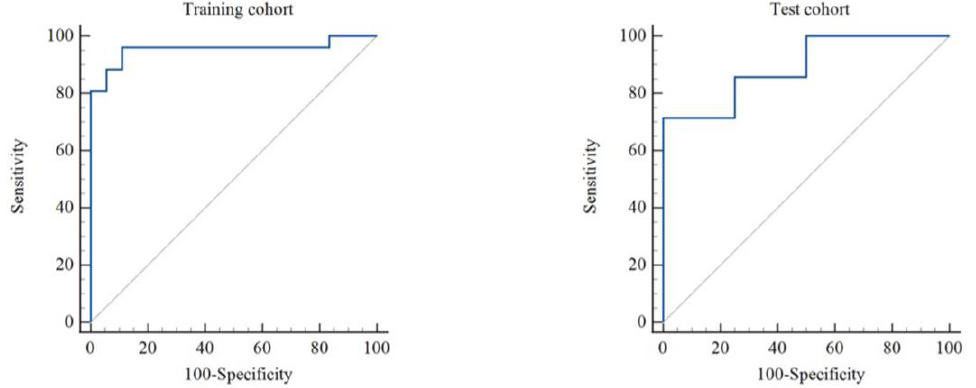
Figure 4. ROC curves of radiomics model in the training and test cohorts. Table 3. Performances of radiomics models for prediction of the short-term therapeutic effect in PAH patients.